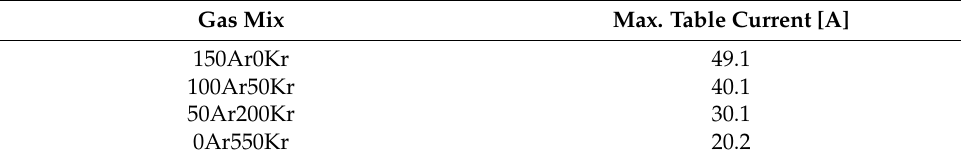
Table 3. Working gas compositions chosen for the main experiments. Gas Mix Max. Table Current [A]